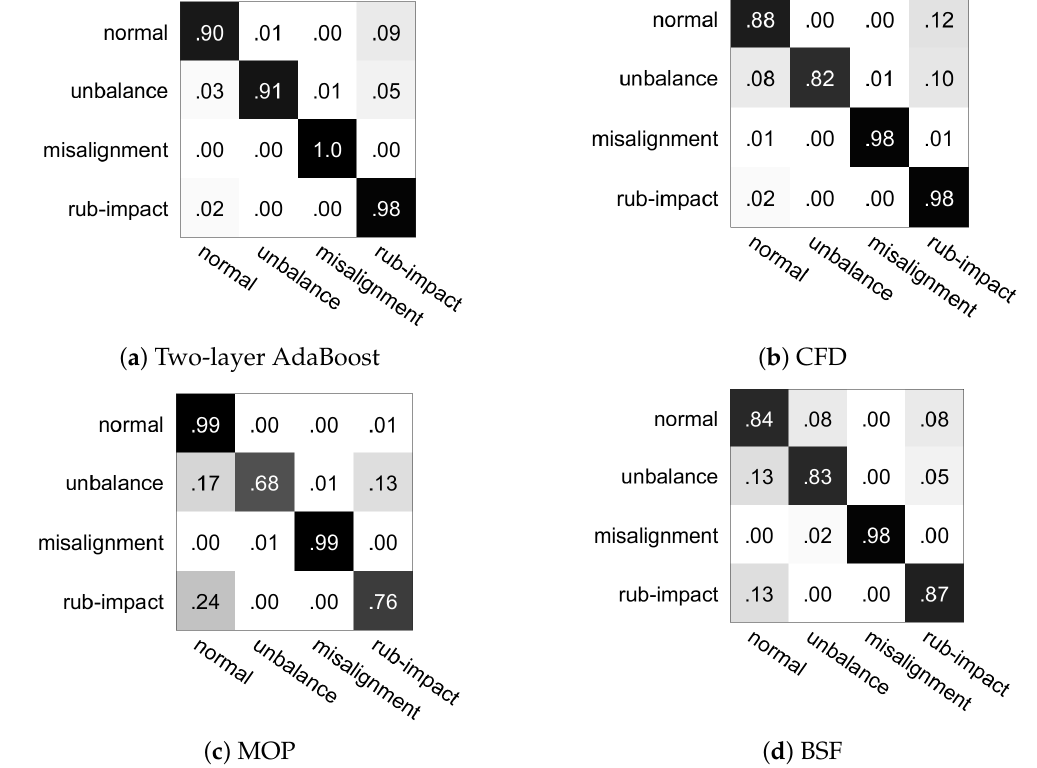
Figure 18. Confusion matrix of different